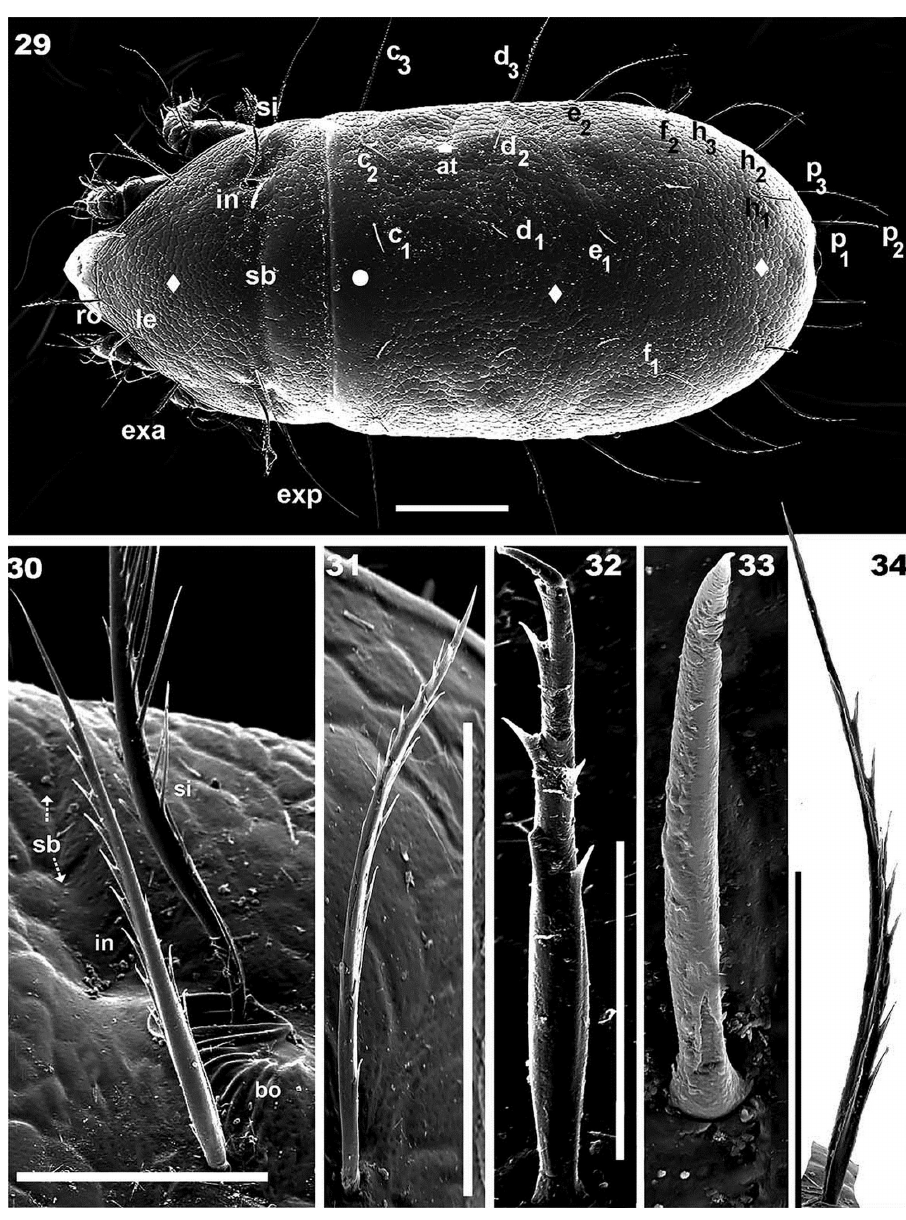
Figures 29–34. Torpacarus eidikoterai sp. n. Adult female with cerotegumental layer. SEM micrographs. 29 dorsal view 30 lateral view, interlamellar setae and sensillus 31 rostral setae 32 c 33 c notogastral setae, variations 34 notogastral setae, lateral view. Scale bars: 100 μm ( 29 ); 30 μm ( 30 ); 1 40 μm ( 31 ); 10 μm ( 32 ); 10 μm ( 33 ); 10 μm ( 34